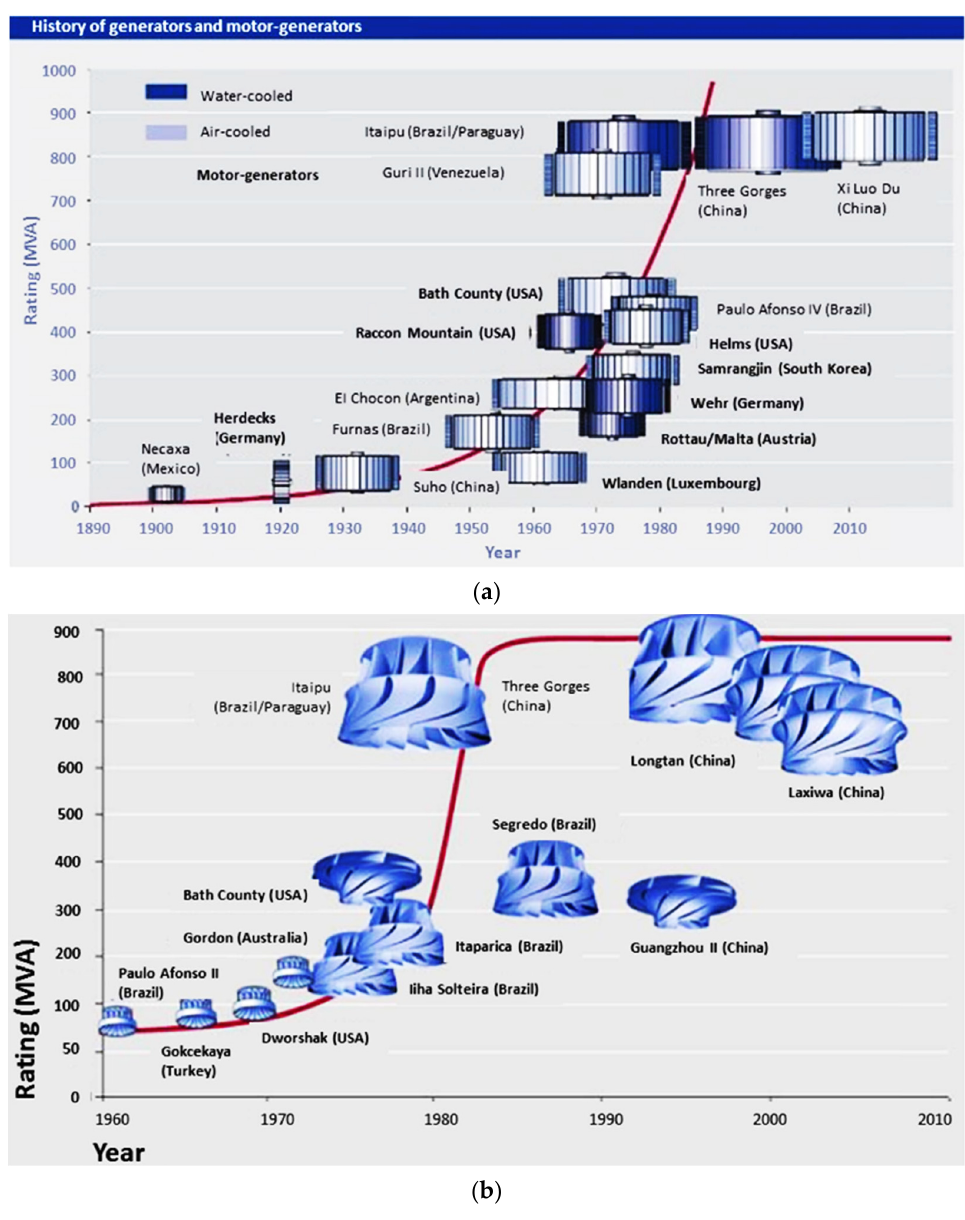
Figure 1. Development of generators and hydraulic turbines in the last century [3]. ( a ) The develop- ment of generators in the last century; ( b ) the development of hydraulic turbines over the last cen- tury.